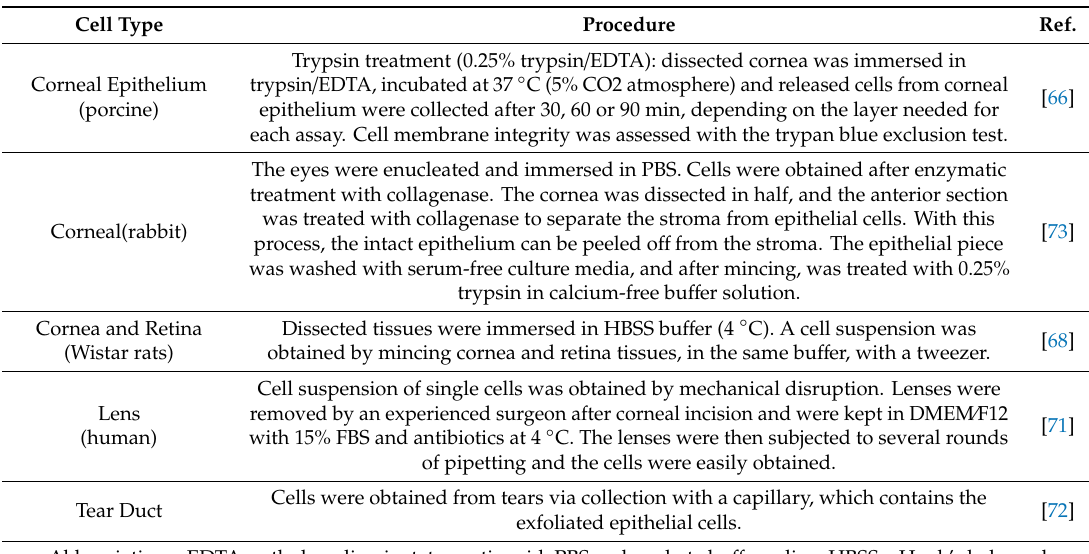
Table 3. Some methods for isolation and separation of cells from di ff erent ocular tissues used for further comet assay